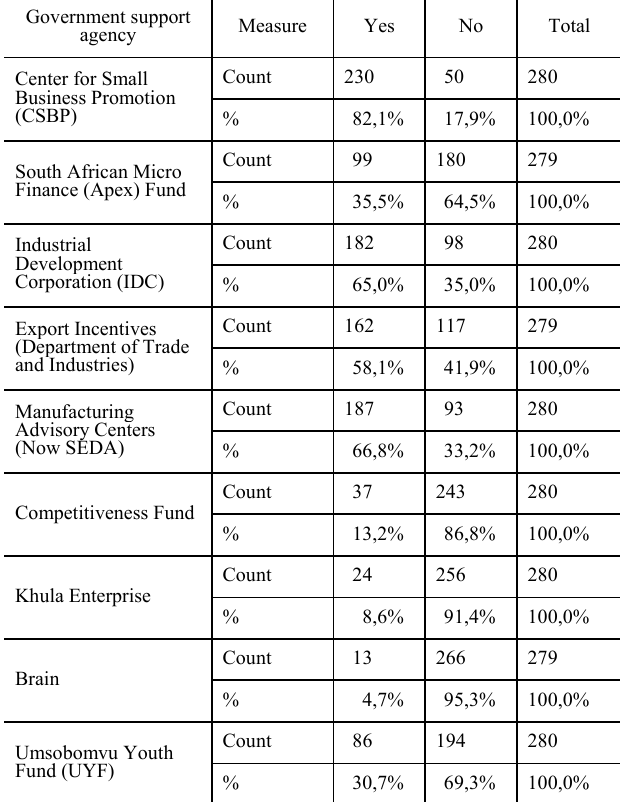
Table 6: Awareness of the government support